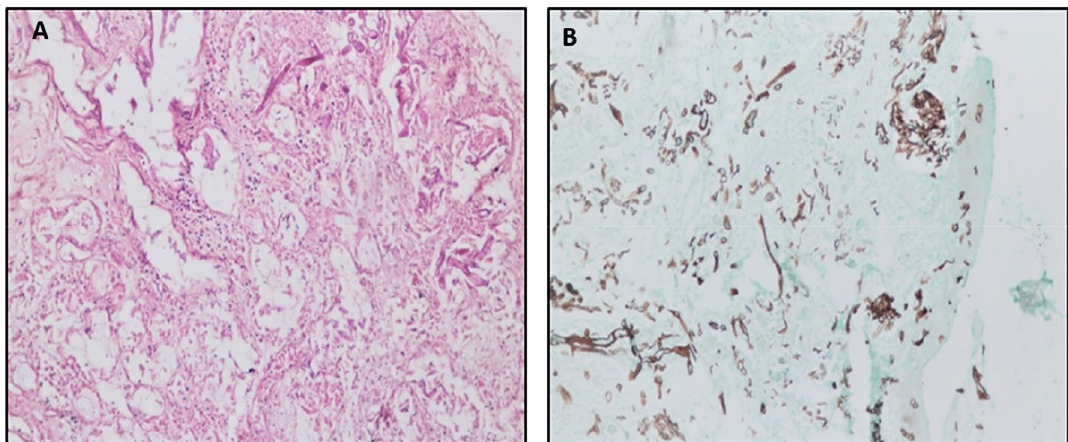
Figure 1. Histopathology of nasal mucormycosis. ( A ) A photomicrograph of a section of nasal mucormycosis that shows obvious necrosis of nasal mucosal glands and mononuclear inflammatory infiltrate (H&E stain, ×200). ( B ) GomoriMethenamine Silver fungal stained section of the same case in this figure highlights branched, thick fungal bodies were invading the nasal mucosal tissue (G.M.S. stain,